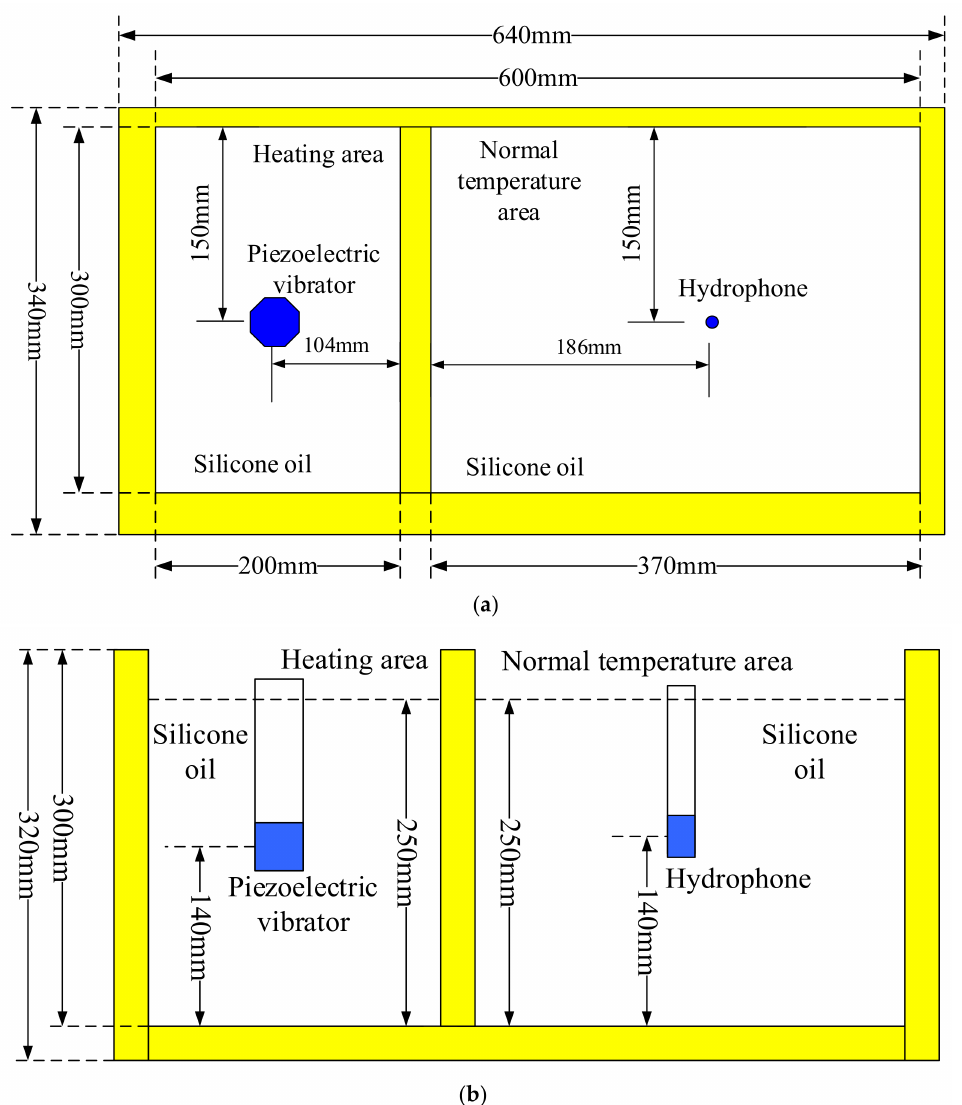
Figure 7. Schematic of the experimental heating device of the transmitting piezoelectric vibrator. ( a ) Vertical view and ( b ) lateral